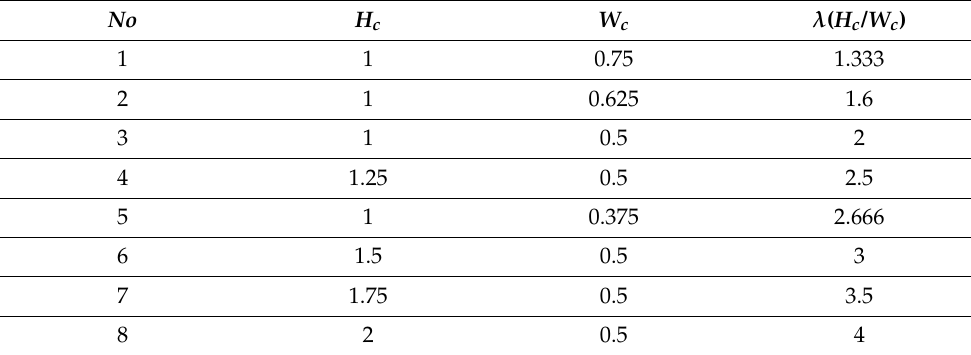
Table 3. Detailed information about the aspect ratio of MC-CR.